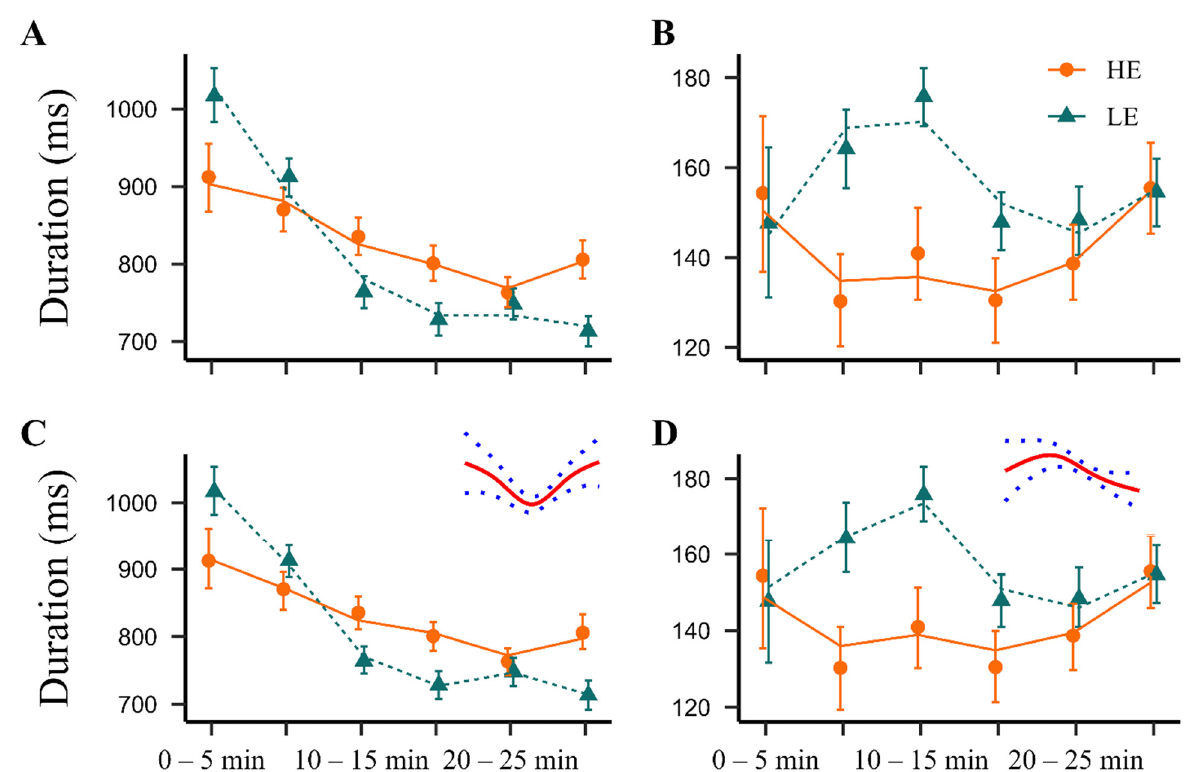
Figure 3. Duration of NPS-induced (1 nmol, i.c.v.) 22 kHz calls. Symbols: Observed time-binned mean durations of long ( A , C ) and short ( B , D ) 22 kHz USVs (error bars indicate 95% confidence limits for the population mean obtained by nonpara- metric bootstrap). Lines: Model-based predictions from linear mixed-effects models (LMM) ( A , B ) and generalised additive models (GAM) ( C , D ; difference in splines added). HE: high exploring rats; LE: low exploring rats; NPS: neuropeptide S. HE NPS ( n = 9); LE NPS ( n = 10).